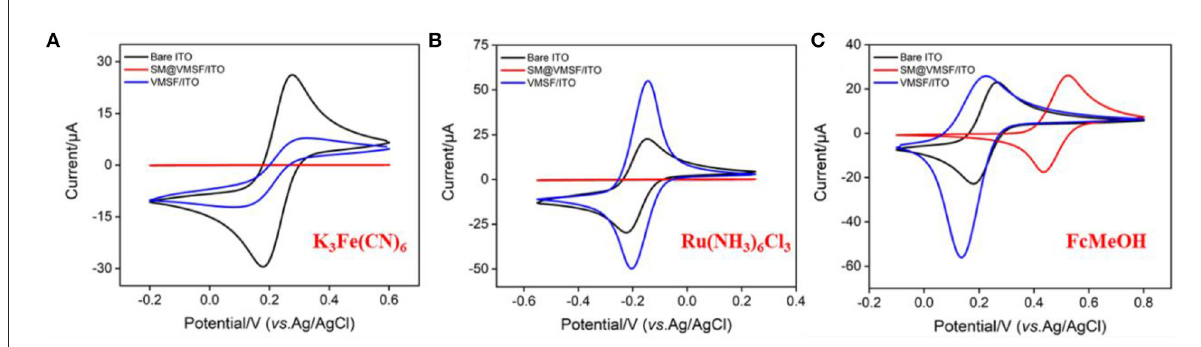
FIGURE2 Cyclic voltametric curves obtained on ITO, SM@VMSF/ITO or VMSF/ITO electrode in K 3 Fe(CN) 6 (A) , Ru(NH 3 ) 6 Cl 3 (B) , and FcMeOH (C) . The redox probe solution (0.5mM) is prepared in KHP (0.05M, pH = 7.4). The scan rate is 50 mV/s.